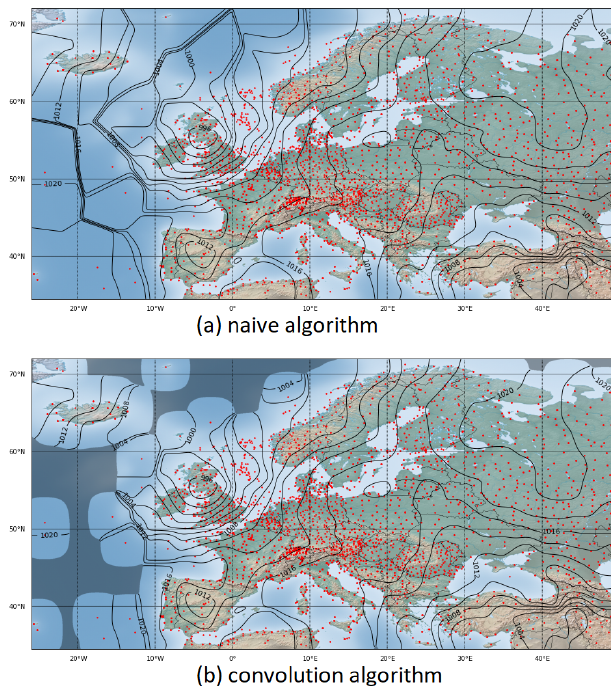
Figure 3. Panel (a) shows exact Barnes interpolation with the naive algorithm for 3490 sample points depicted in red, a 2400 × 1200 grid with a resolution of 32 grid points per degree and σ = 1 . 0 ◦ . Panel (b) shows approximate Barnes interpolation with the convo- lution algorithm for the same settings as for the naive algorithm above. The applied 4-fold convolution uses a rectangular mask of size 57. Areas where the denominator of Eq. (9) drops below a value of 0 . 001 or is even 0 are rendered with a darker